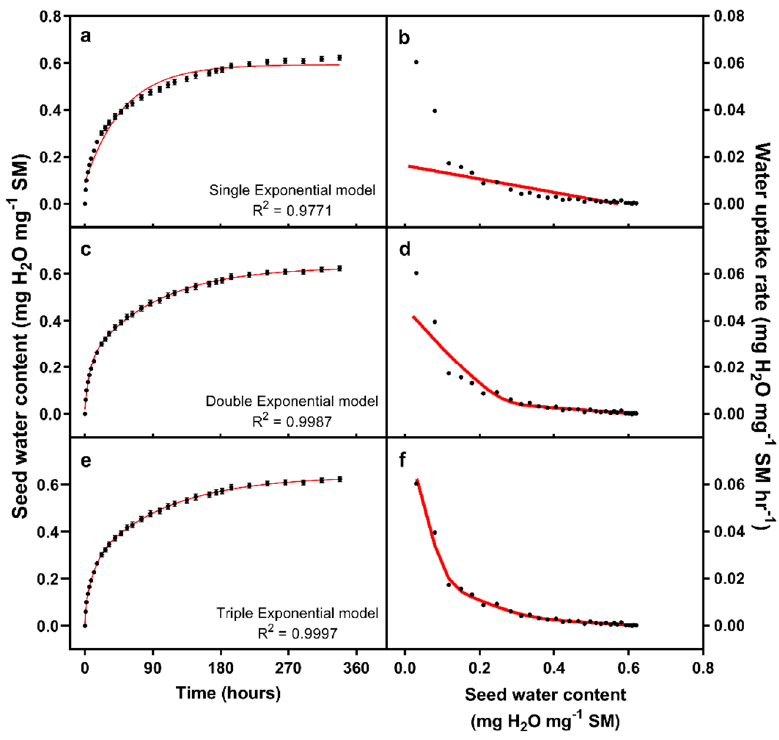
Figure 3. Seed water uptake kinetics fitted with a single ( a ), double ( c ), or triple ( e ) exponential curve. Seed water uptake rates were calculated and plotted against seed water content, for the data (points), and the regression models (red lines, Figure ( b , d , f )). Table 1. Curve-fit parameters of single, double, and triple exponential models fitted to water uptake data for water control seeds in Figure 3. Numbers in parentheses represent the 95% confidence in- tervals of the estimates. An extra-sum-of-squares F-test was used to determine whether a more com- plex model fit the data significantly better than the immediately simpler model.